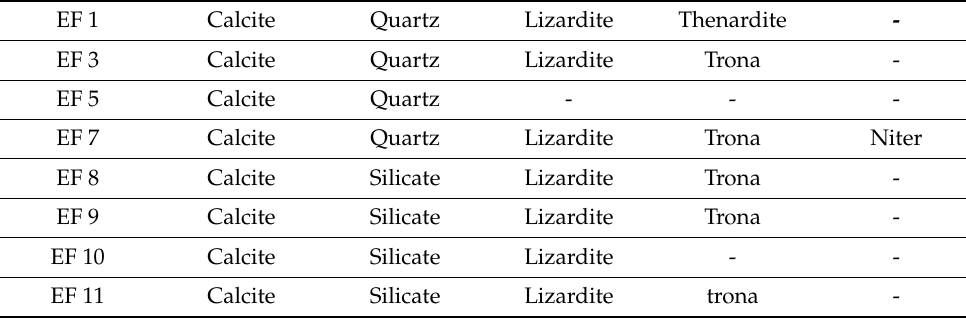
Table 3. Composition of efflorescence obtained by FT-IR